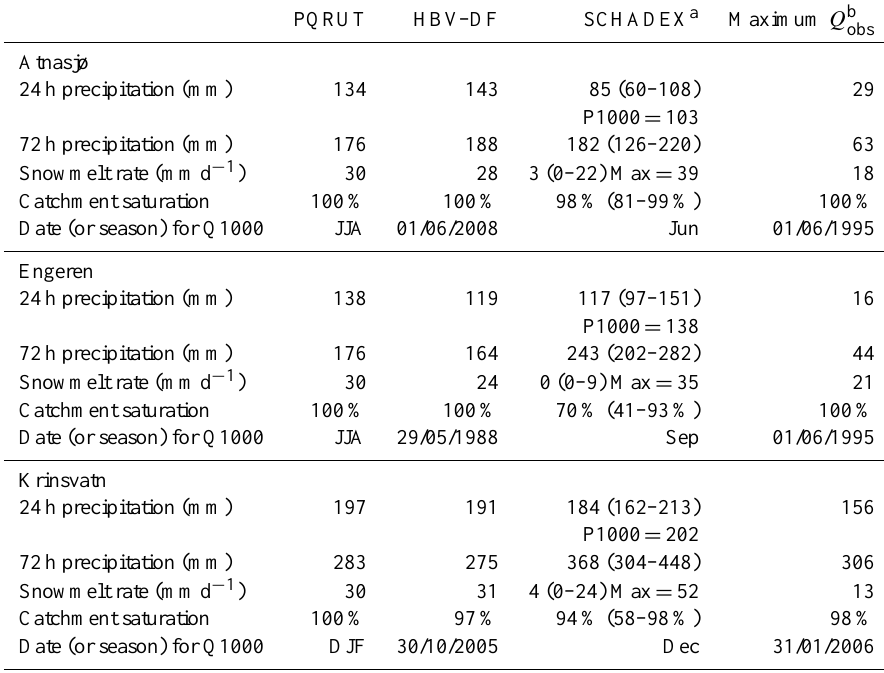
Table 2. Comparison of precipitation, snowmelt, catchment saturation conditions and the date of occurrence for the design 1000-year flood values simulated by the three modelling methods, as compared with the conditions associated with the highest observed discharge values for each